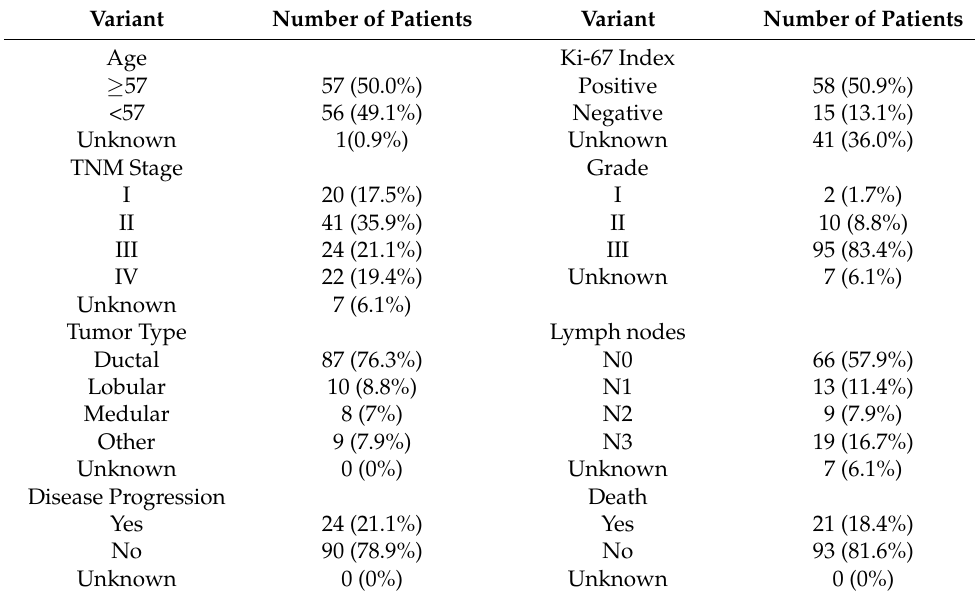
Table 1. Clinicopathological characteristics of triple-negative breast cancer patients ( n =